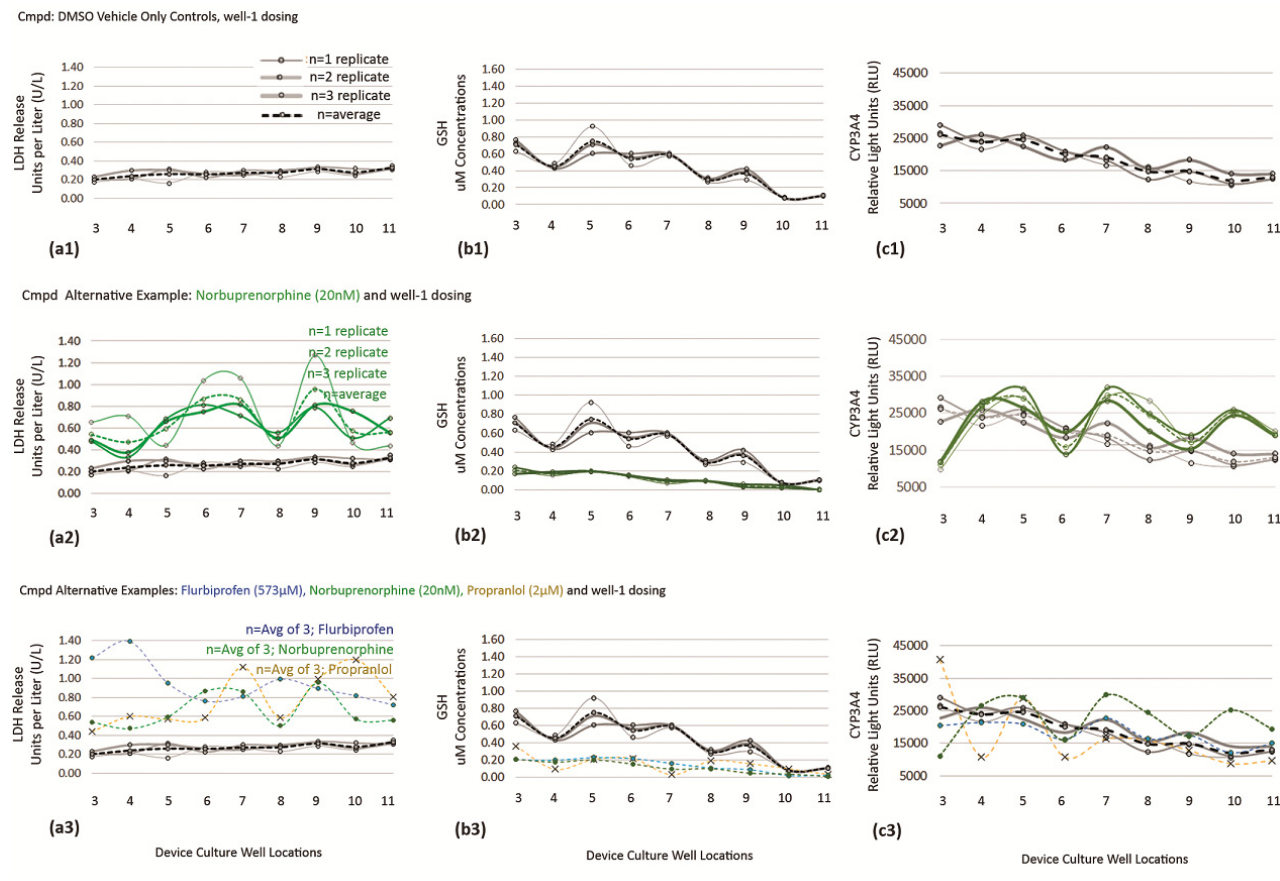
Figure A1. DMSO controls and drug data replicates. ( a1 , b1 , c1 ) DMSO controls only. ( a2 , b2 , c2 ) DMSO controls vs. compound norbuprenorphine. ( a3 , b3 , c3 ) DMSO controls vs. compounds flurbiprofen, norbuprenorphine, and propranlol.